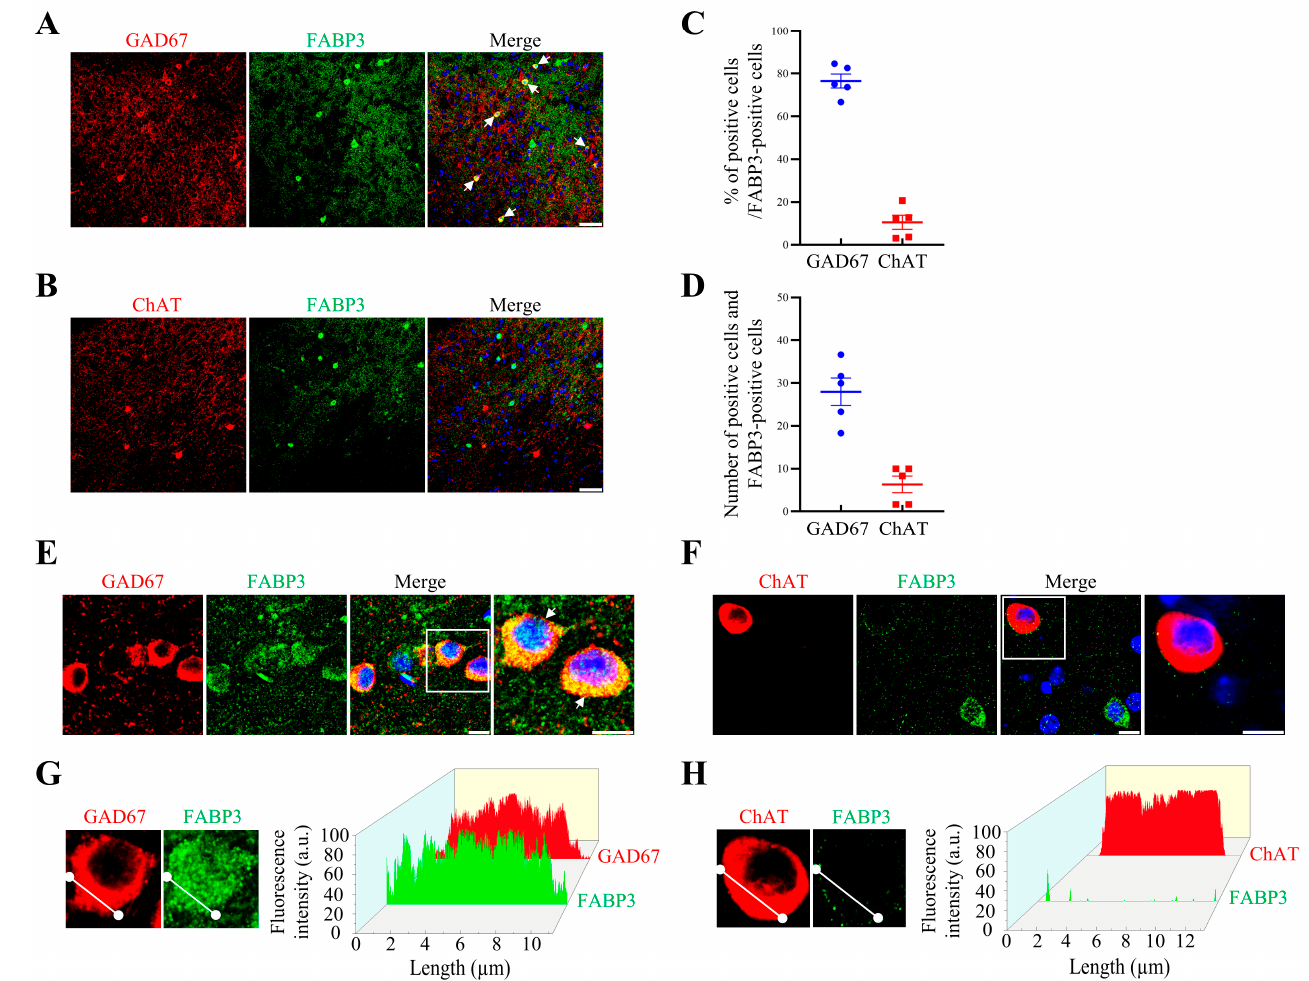
Figure 5. Colocalization of FABP3 in the NAc. ( A – D ) Representative images and quantitative percentage data of GAD67-positive cells (red) and ChAT-positive cells (red) colocalized with FABP3 (green), and the number of GAD67 and ChAT/FABP3 double-positive cells in the NAc. Most GAD67-positive cells—but not ChAT-positive cells—were observed to coexist with FABP3 ( n = 5 per group). DAPI-stained nuclei are shown in blue. Error bars represent SEMs. Scale bars 100 µm. ( E – H ) Representative magnified images of GAD67, ChAT, and FABP3, and surface plots of fluorescence intensity, shown individually. Results are in agreement with the above-mentioned data and clearly indicate that most GAD67-positive cells, but not ChAT-positive cells, are colocalized with FABP3 in the NAc. Surface plots were measured and reconstructed using Fiji (Fiji Is Just ImageJ) (Version 1.53u) and OriginPro 2021b (9.85) software. a.u., arbitrary unit. Scale bars 10 µm. The immuno fl uo- rescence analysis utilized data symbols, speci fi cally solid dots and squares, to represent individual values, with each symbol color-coded using blue or red to di ff erentiate between di ff erent positive cells. 3. Discussion In the present study, we report, for the fi rst time, that MF1 treatment successfully prevents chronic nicotine-induced CPP acquisition in mice. We con fi rmed that this amelioration using MF1 was closely correlated with reduced CaMKII and ERK activities and reductions in DA receptor levels. Inhibition of the increase in CaMKII activity was correlated with CREB phosphorylation and c-Fos expression in mouse NAc. MF1 treatment signi fi cantly inhibited QNP-induced increase in CaMKII and ERK phosphorylation in cultured NAc slices from WT mice, whereas the treatment did not a ff ect CaMKII and ERK phosphorylation in slices from D2R null mice. Taken together, the